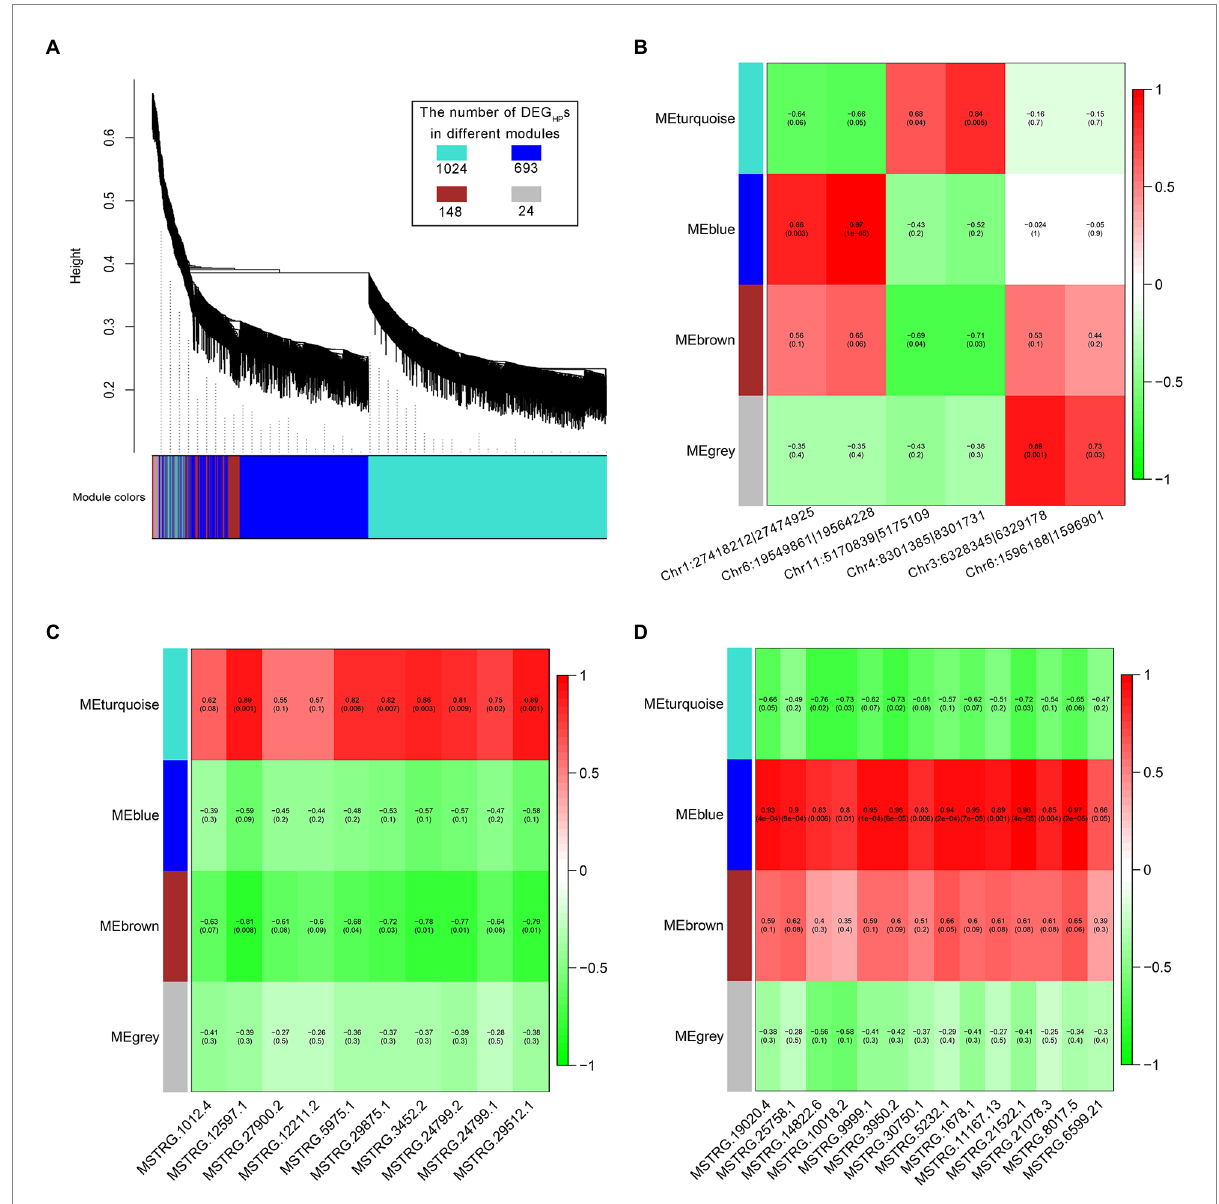
FIGURE 5 The regulation of non-additive expressed ncRNAs on DEGHPs. (A) Four expression patterns of DEGHPs obtained by WGCNA analysis. (B) Correlation analysis of non-additive expressed circRNAs and DEGHPs. (C) Correlation analysis of ELD-P expressed lncRNAs and DEGHPs. (D) Correlation analysis of ELD-M expressed lncRNAs and